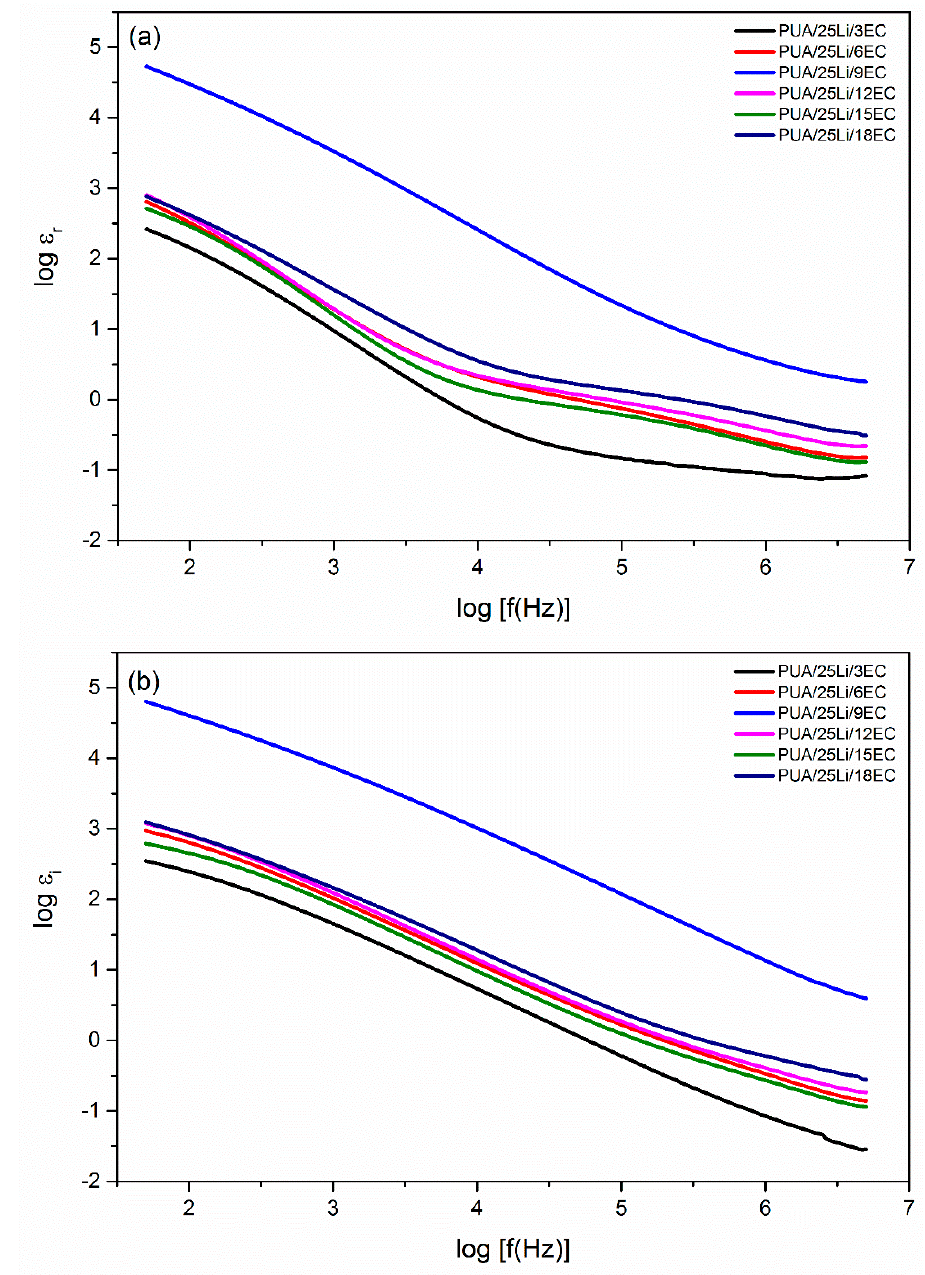
Figure 7. Variation of ( a ) log ε r and ( b ) log ε i versus log frequency PUA/LiClO 4 /EC electrolytes.